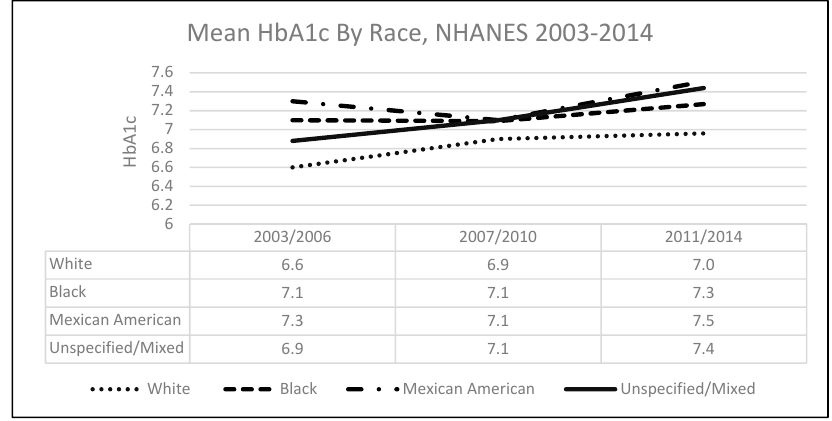
Figure 1. Mean HbA1c by race/ethnicity, NHANES 2003–2014.